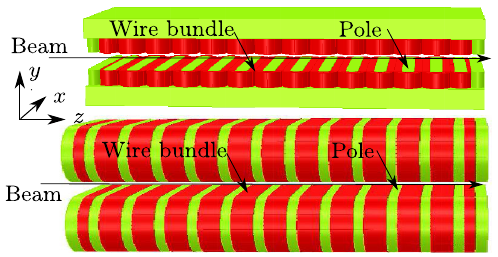
FIG. 4. Horizontal (top) and vertical (bottom) racetrack wiggler magnets.